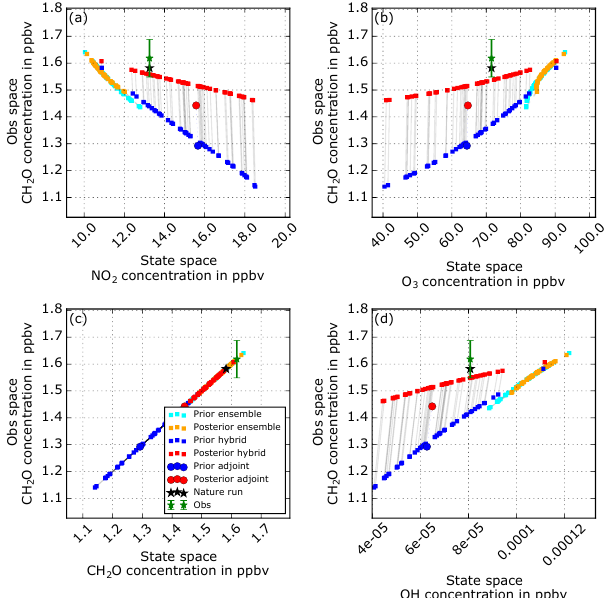
Figure 8. Tracer–tracer or observation space to state space relation- ships during the ninth cycle of the CH 2 O assimilation without lo- calization experiment.